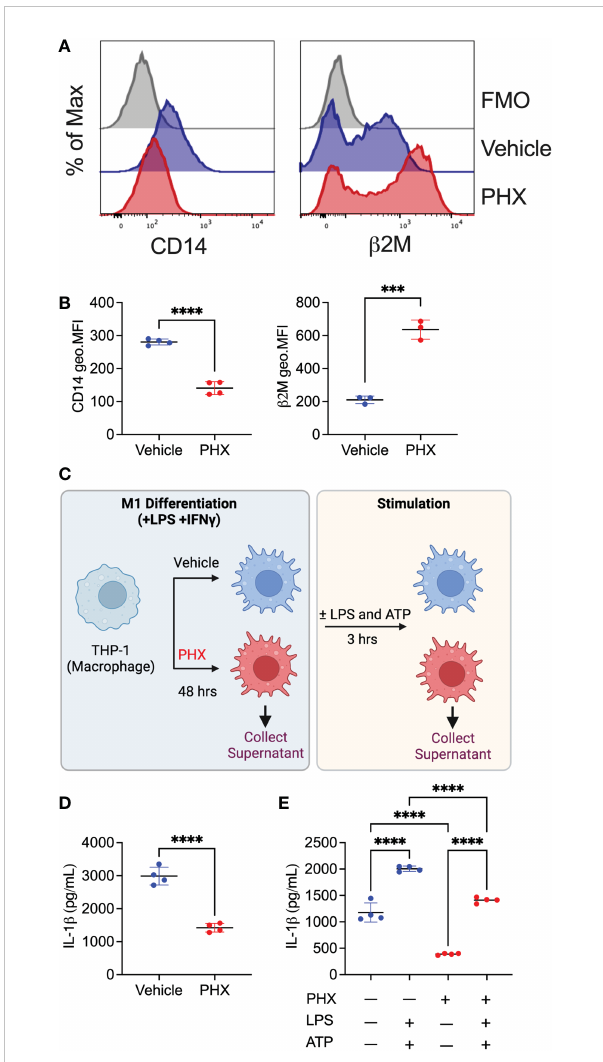
FIGURE 7 Validation of proteomics data set. THP-1 derived M1 macrophages cultured with 5 m M PHX or vehicle control were examined for changes in expression of proteins by fl ow cytometry or ELISA. (A) Histogram plots and (B) quantitation of geometric mean fl uorescence intensity (geo.MFI) for the expression of CD14 and b 2M on CD80+ macrophages. (C) Experimental work fl ow describing the collection of supernatants for IL-1 b detection. Supernatants (D) prior to stimulation or (E) after stimulation with LPS and ATP was collected from PHX-treated M1 macrophages. Data are pooled 3-4 replicates and presented as mean ± SD. Student ’ s t-test or One-way ANOVA with Dunnett's multiple comparisons test was performed for the analysis. *** p ≤ 0.001; **** p ≤